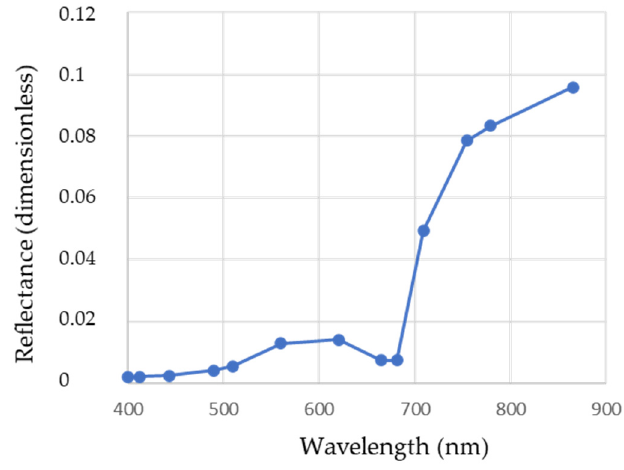
Figure 3. Spectral reflectance of pure Sargassum [20].